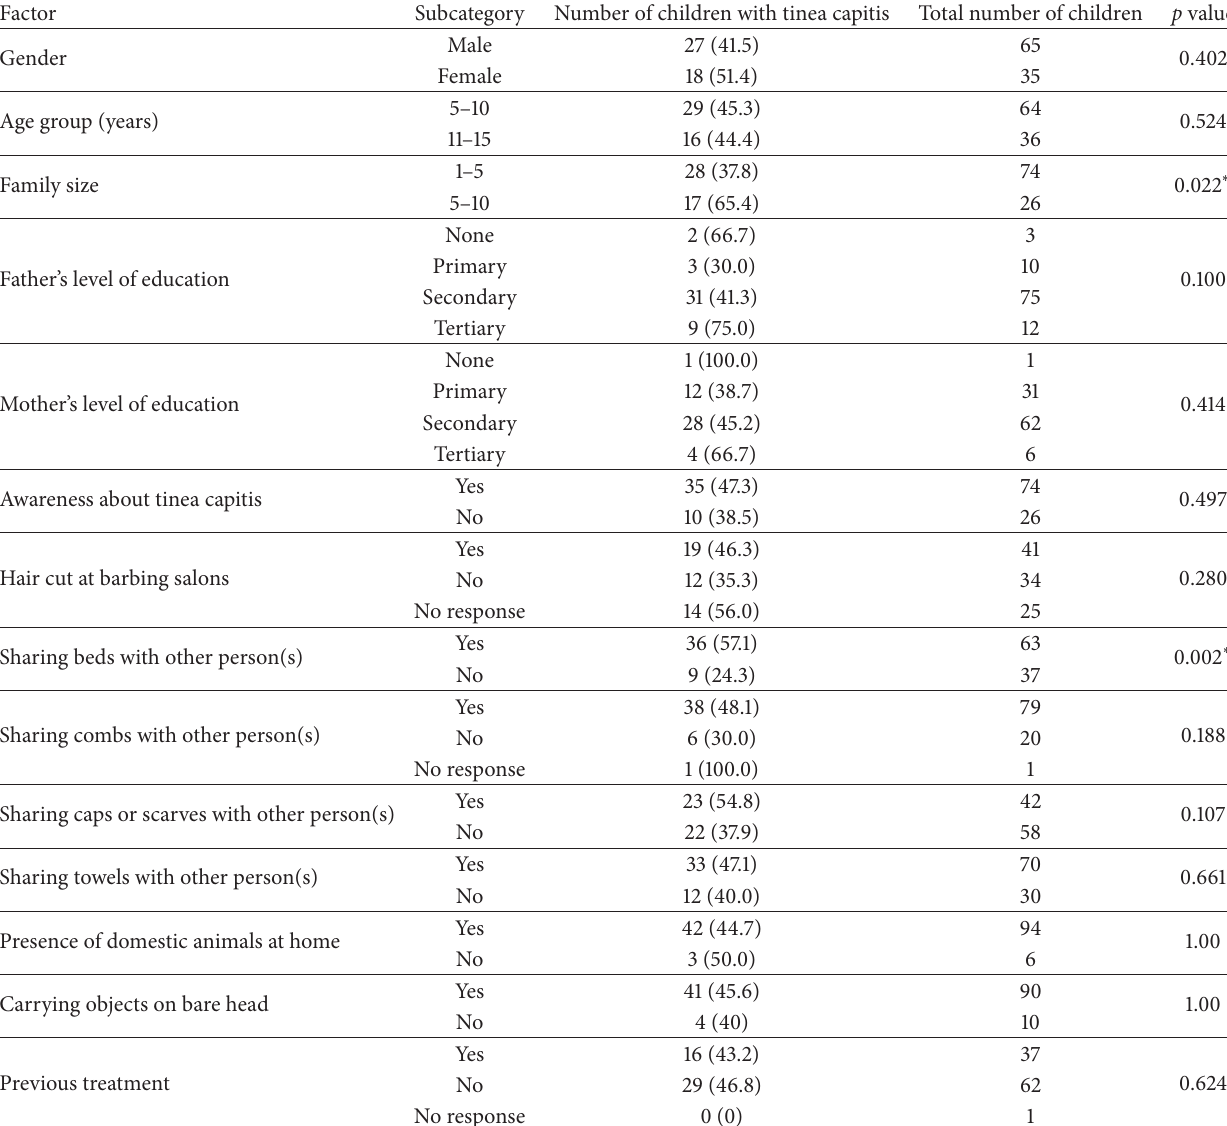
Table 1: Demographic data and other factors in relation to tinea capitis among school children in Nok community, Kaduna State, Nigeria.